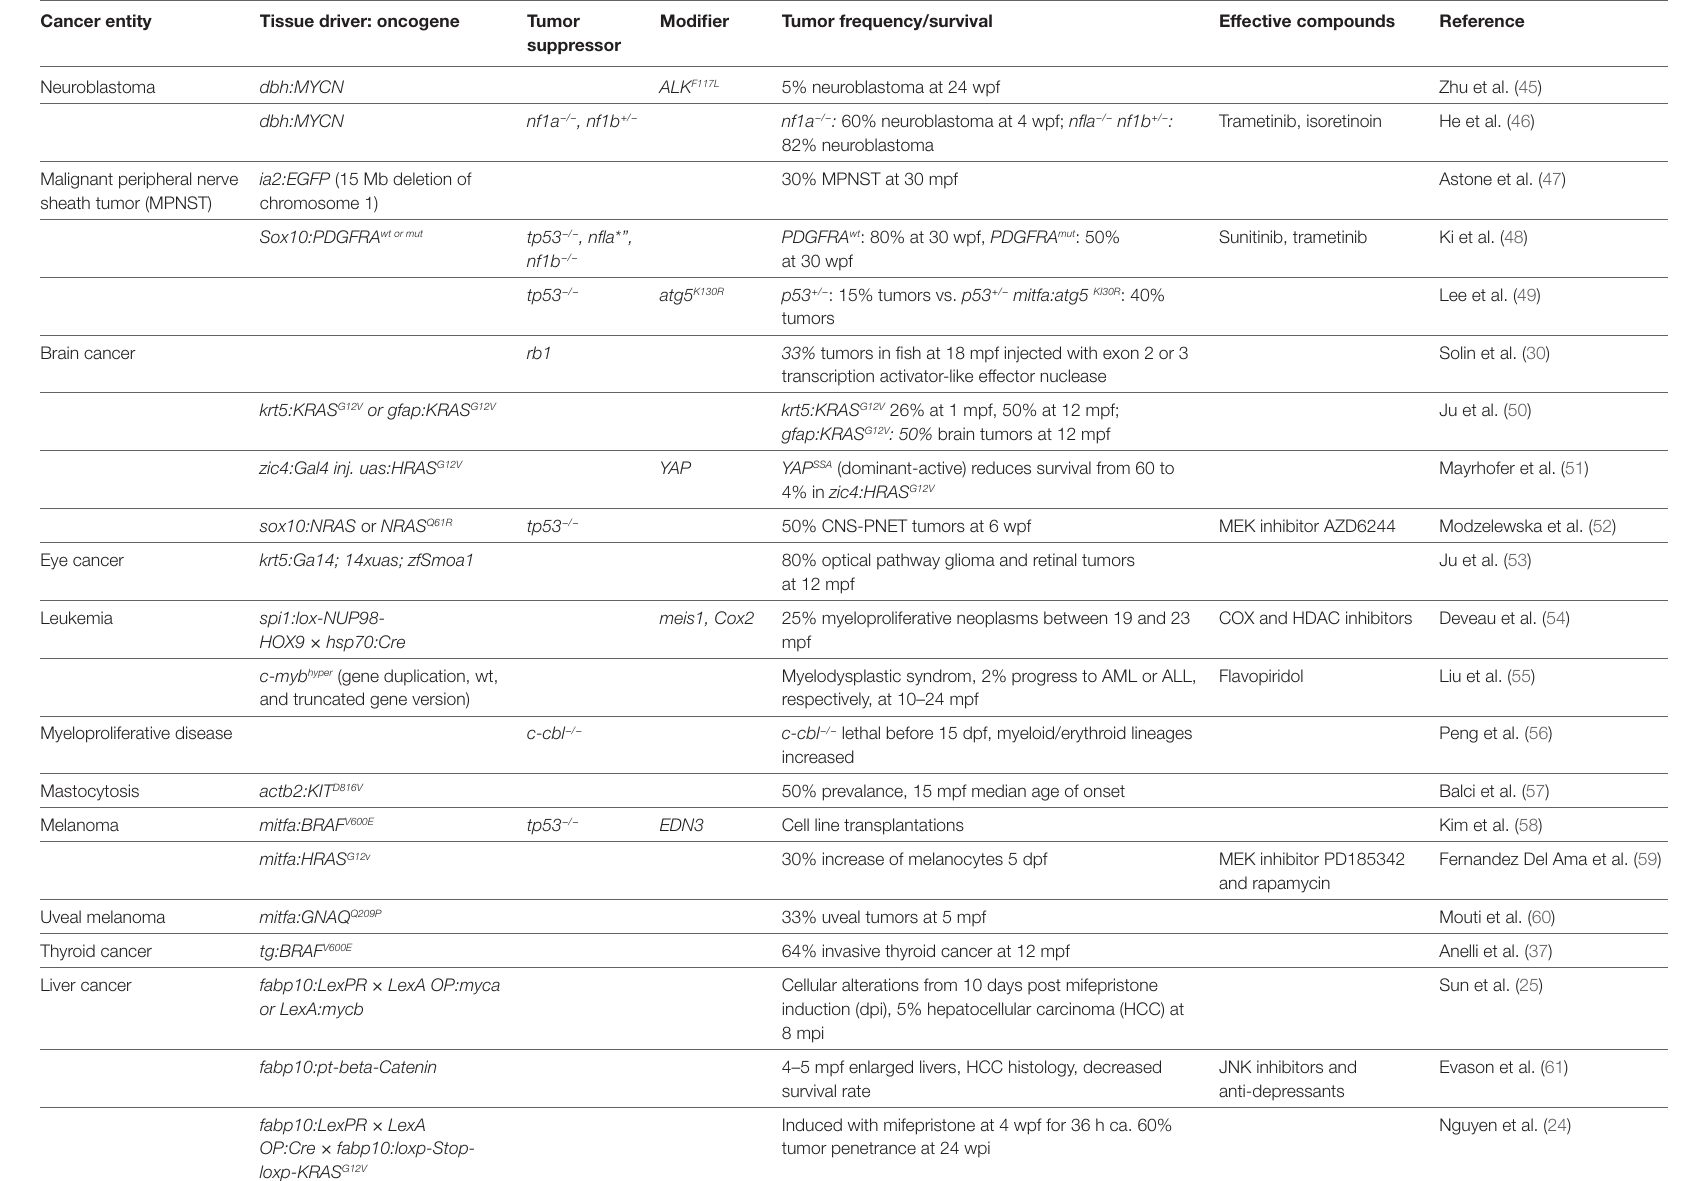
TABLe 1 | Recently developed and improved zebrafish cancer